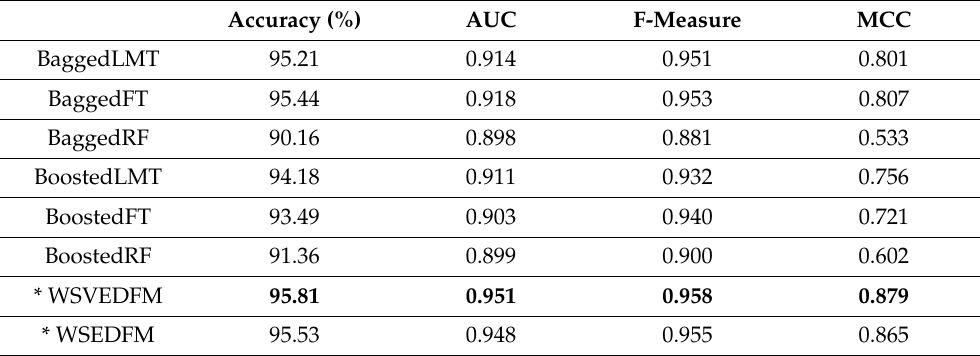
Table 11. The CCP performance comparison of WSVEDFM and WSEDFM with Bagged and Boosted DF models on Dataset 1.